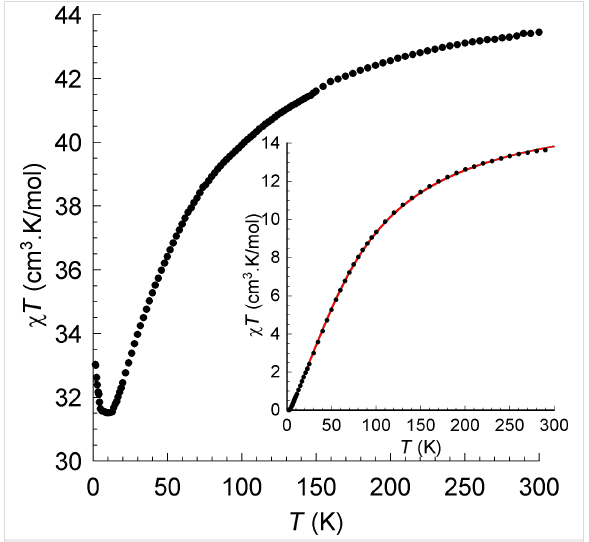
Figure 3: χ T -vs- T plots at 0.1 T for 1 and 2 (inset). The solid line is the best fit to the experimental data.